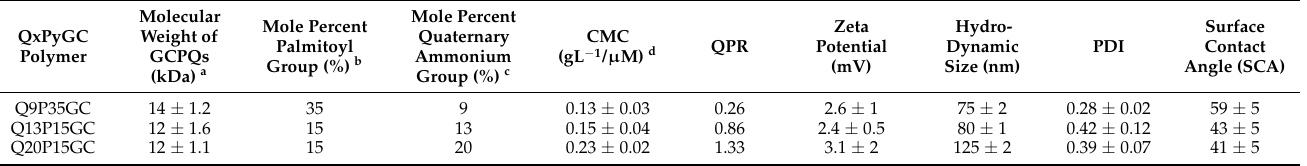
Table 1. Physiochemical characterization of GCPQ polymers.